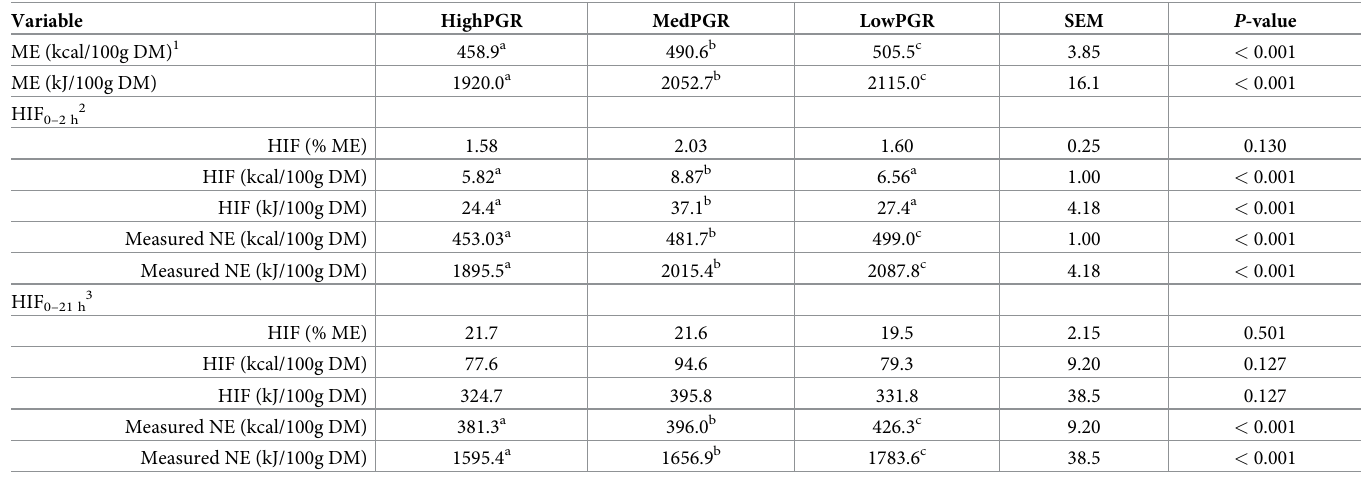
Table 4. ME and HIF used to determine NE per 100g of